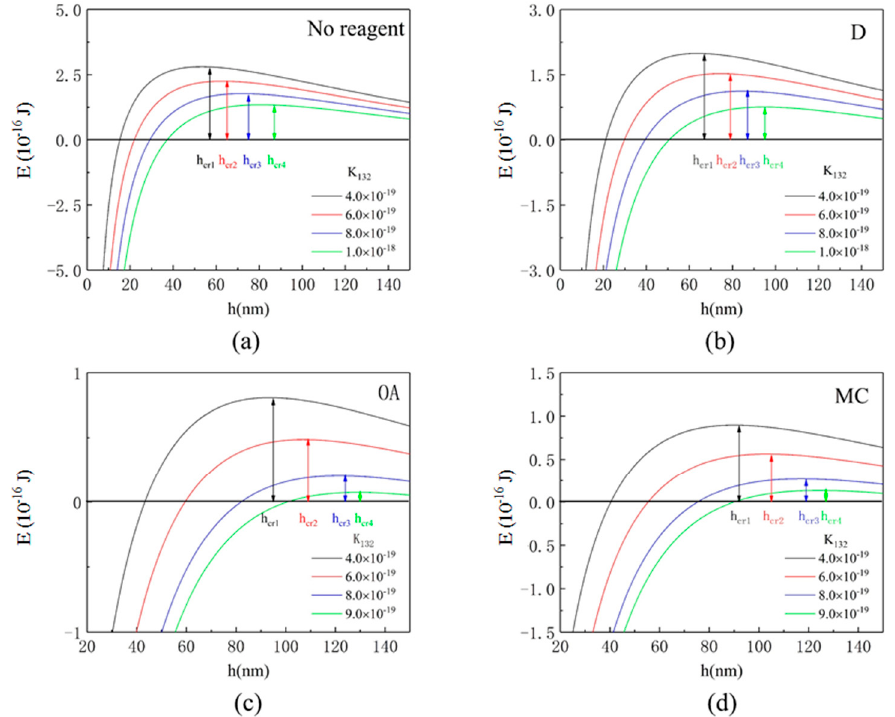
Figure 4. Relationship of interaction energy and film thickness between air bubble and coal treated with ( a ) no reagent, ( b ) n-dodecane, ( c ) oleic acid, and ( d ) mixed collector. As shown in Figure 4, each hydrophobic force constant (cid:2167) (cid:2778)(cid:2780)(cid:2779) corresponds to a critical film thickness (cid:2190) (cid:2185)(cid:2200) . The hydrophobic force constant (cid:2167) (cid:2778)(cid:2780)(cid:2779) and corresponding critical film thickness (cid:2190) (cid:2185)(cid:2200) is listed in Table 3. There is a linear relationship between (cid:2190) (cid:2185)(cid:2200) and (cid:2167) (cid:2190) (cid:2167) (cid:2778)(cid:2780)(cid:2779) [10], as shown in Figure 5. The (cid:2185)(cid:2200) increases with the increasing of (cid:2778)(cid:2780)(cid:2779) , and in- creases in order of no reagent < D < MC < OA at the same (cid:2167) (cid:2778)(cid:2780)(cid:2779) . The (cid:2190) (cid:2185)(cid:2200) of coal treated by collectors is thicker than the coal without collector treatment. The (cid:2190) (cid:2185)(cid:2200) of coal treated by OA and MC is thicker than D, which indicates the higher hydrophobicity of coal sur- face treated by OA and MC [45]. The larger (cid:2190) (cid:2185)(cid:2200) value means that the wetting film is easier to rupture and the attachment between air bubble and coal occurs more easily [4]. Table 3. The hydrophobic constant and the corresponding wetting film thickness of coal treated with different reagent. (cid:2190) (cid:2185)(cid:2200)